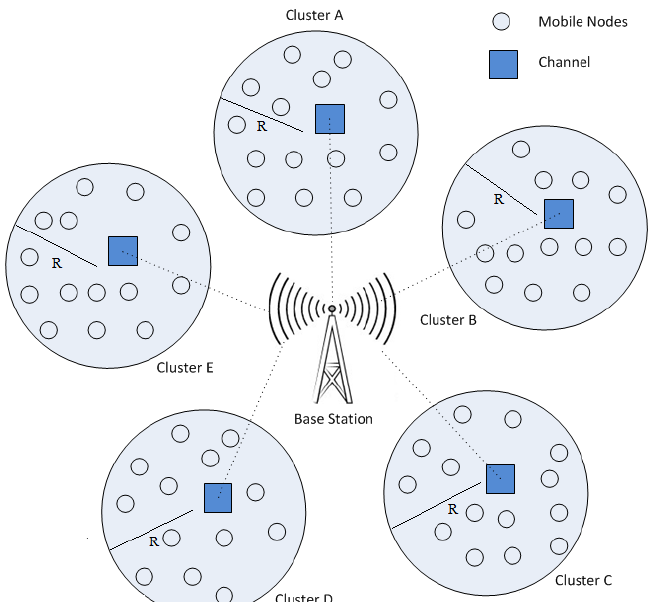
Figure 1. Cluster in MWSN.